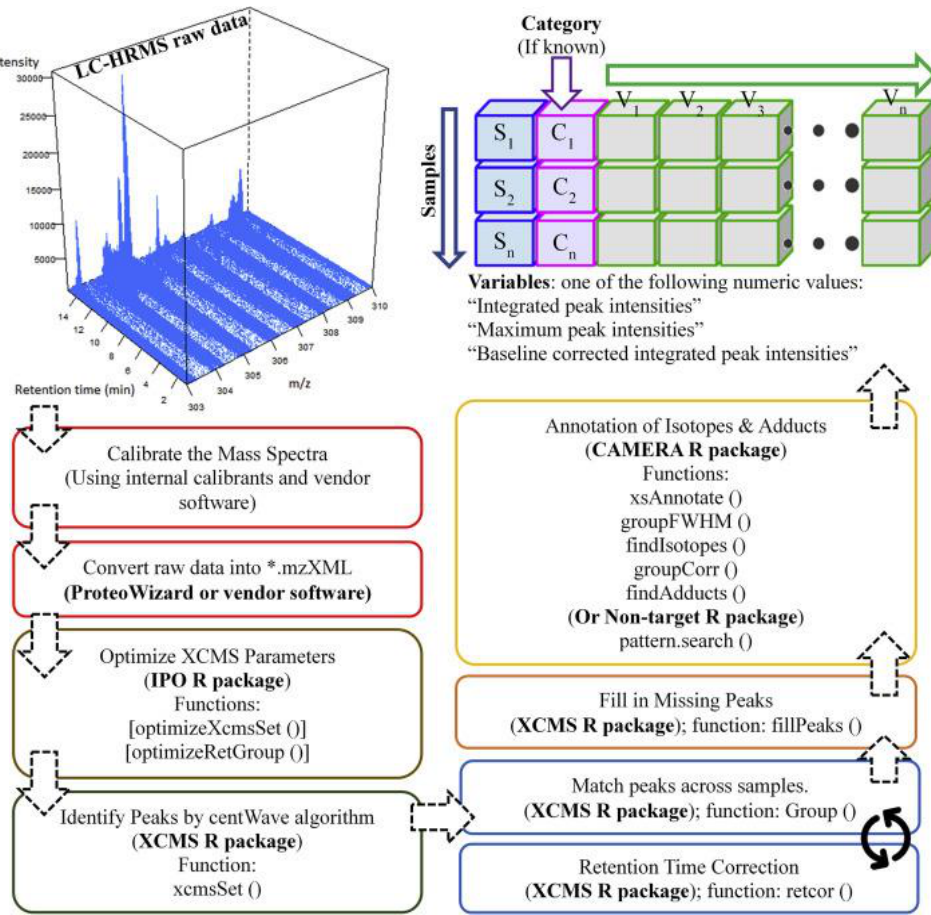
Figure 6. Peak-picking workflow with XCMS [34]. Reprinted from [34] Copyright 2020, with permission from Elsevier.